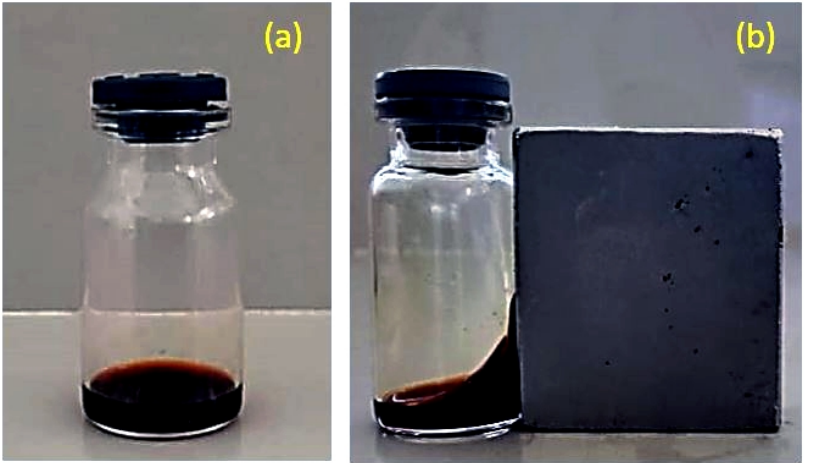
Figure 6. Photographs of the Zn-doped aqueous magnetite ferrofluids (a) with and (b) without an external magnetic